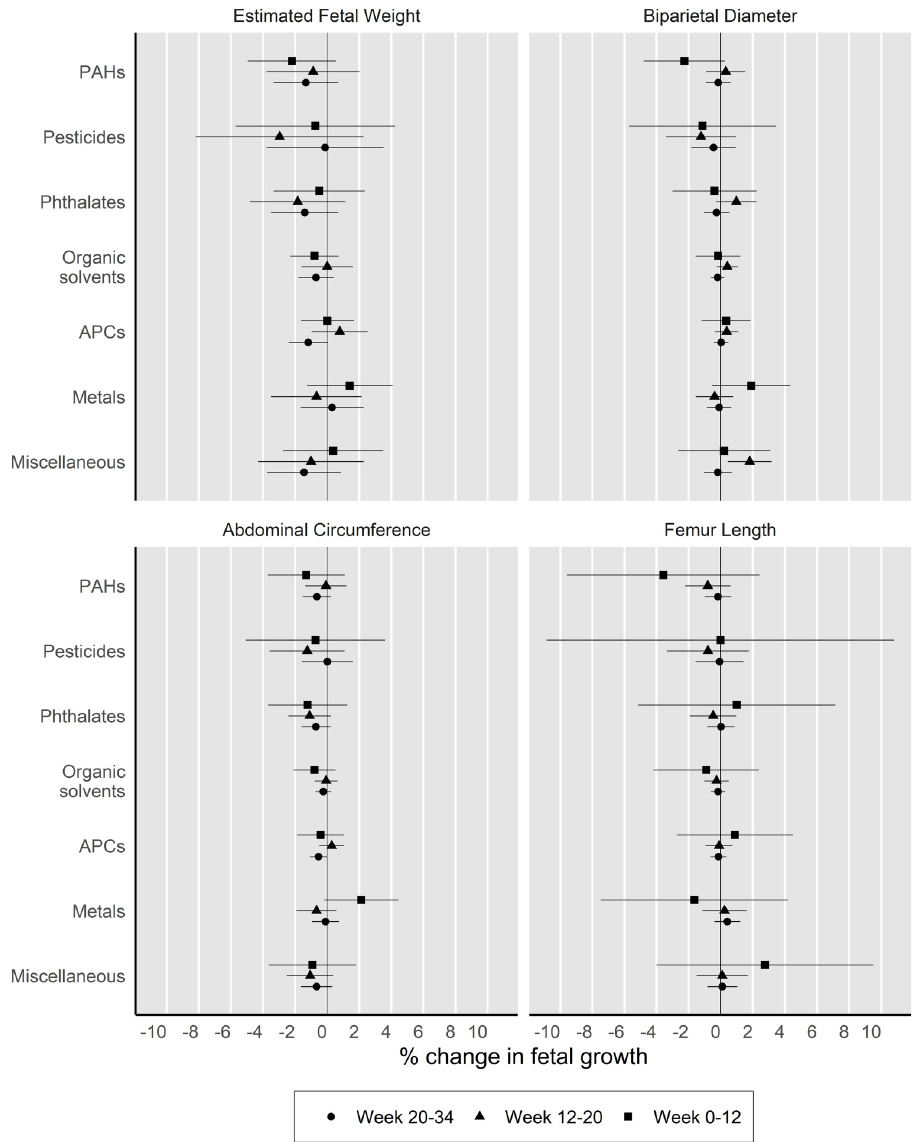
Fig 2. Associations between exposure to endocrine disrupting chemical (EDC) groups and growth trajectories for each fetal parameter, INMA, 2003-2008. 2. Estimates and their respective 95% confidence intervals are presented as the percentage change in fetal growth compared to participants with unlikely exposure to the respective EDC group at different stages of pregnancy. Models are adjusted for maternal age at birth in years, maternal education, country of birth, gestational weight gain, pre-pregnancy body mass index, active smoking during pregnancy, alcohol consumption during pregnancy, parity and shift work. PAHs: Polycyclic aromatic hydrocarbons, APCs: Alkylphenolic compounds, EFW: Estimated fetal weight (n = 1,403), BPD: Biparietal diameter (n = 1,408), AC: Abdominal circumference (n = 1,410), FL: Femur length (n = 1,409). Numeric estimates are presented in Supplemental Material, S3